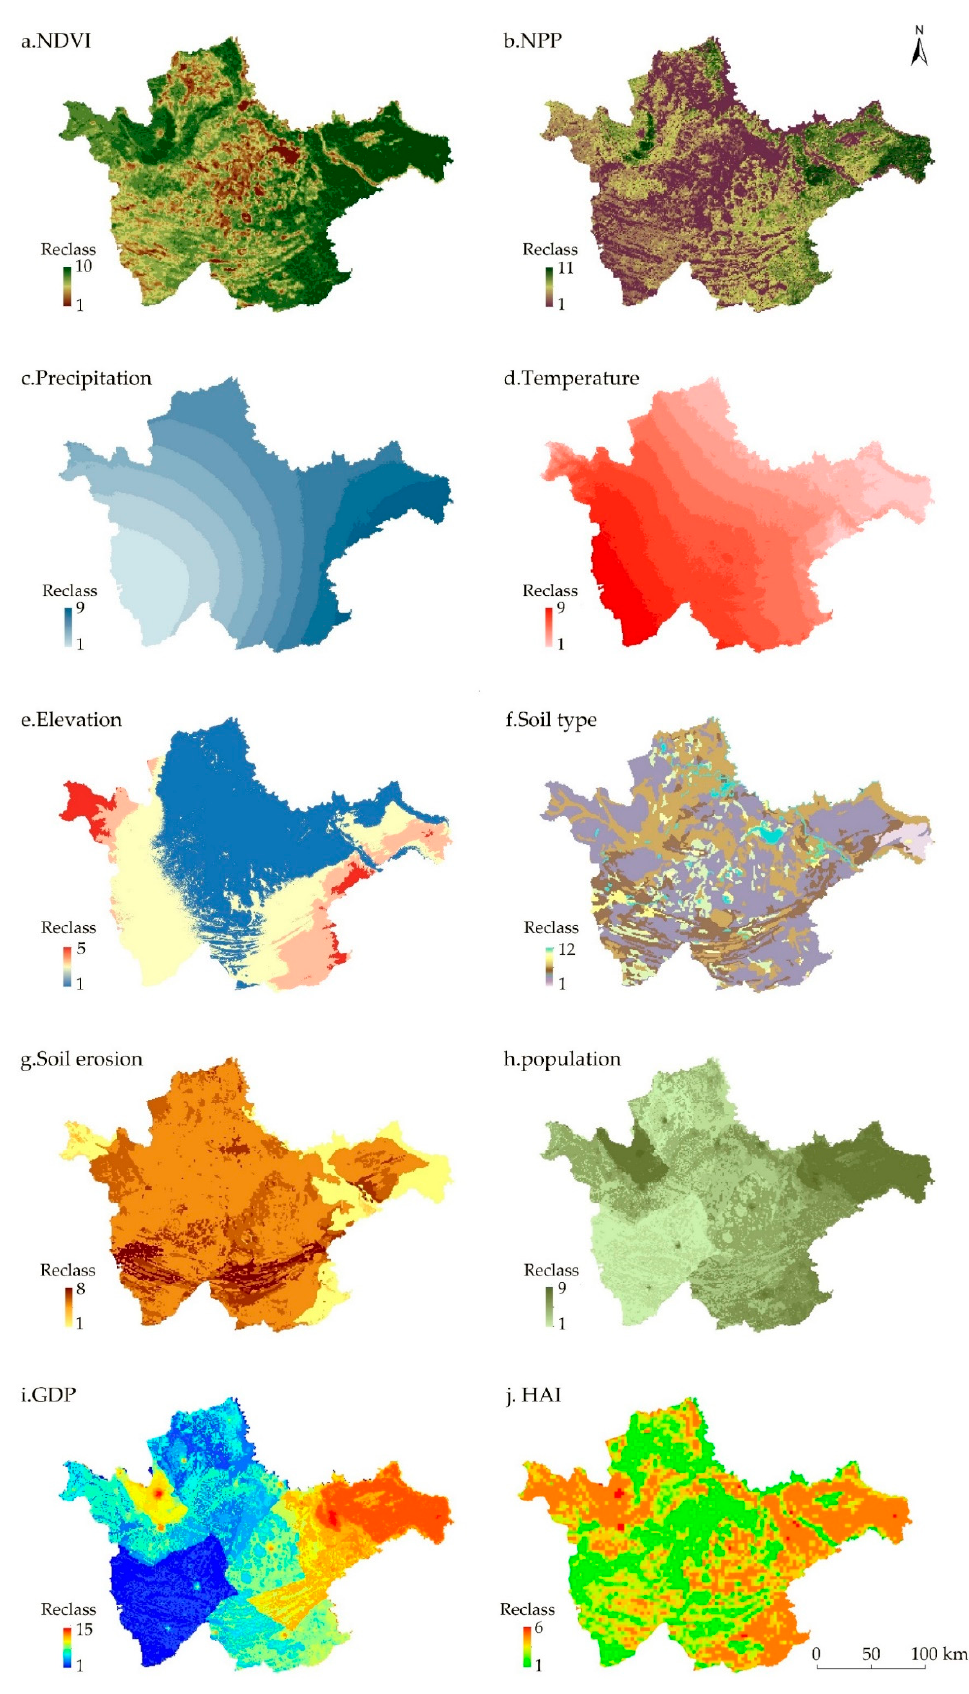
Figure 2. Spatial distribution of driving